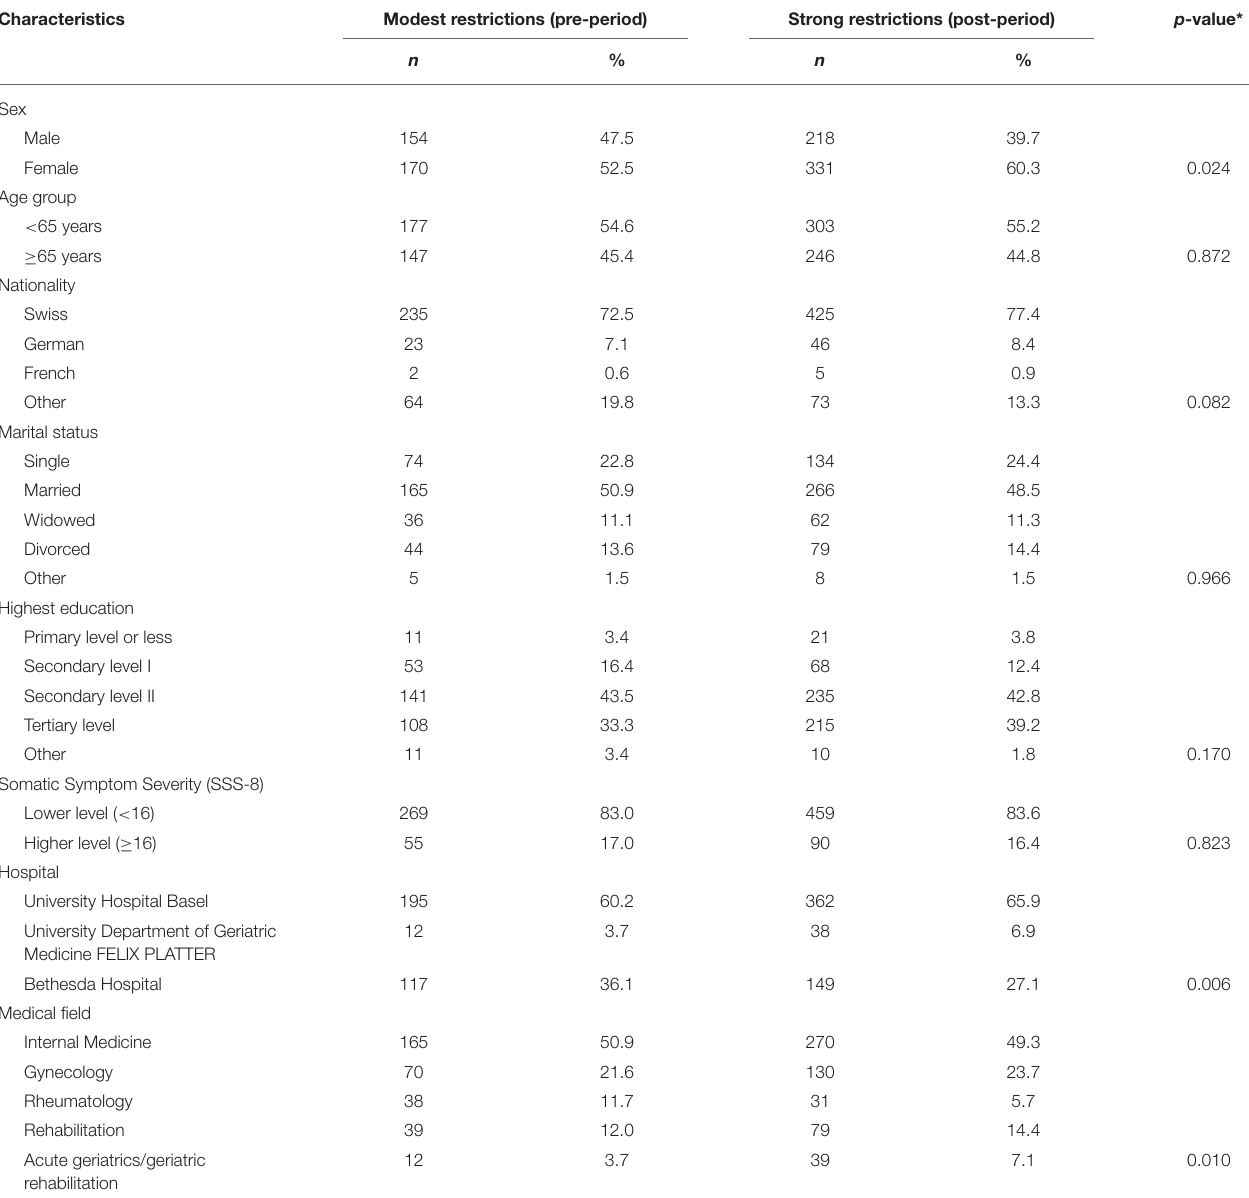
TABLE 2 | Patient characteristics, admitting hospital, and medical specialty of wards at which recruitment took place during modest ( n = 324) and strong ( n = 549) coronavirus disease 2019 (COVID-19) restrictions.